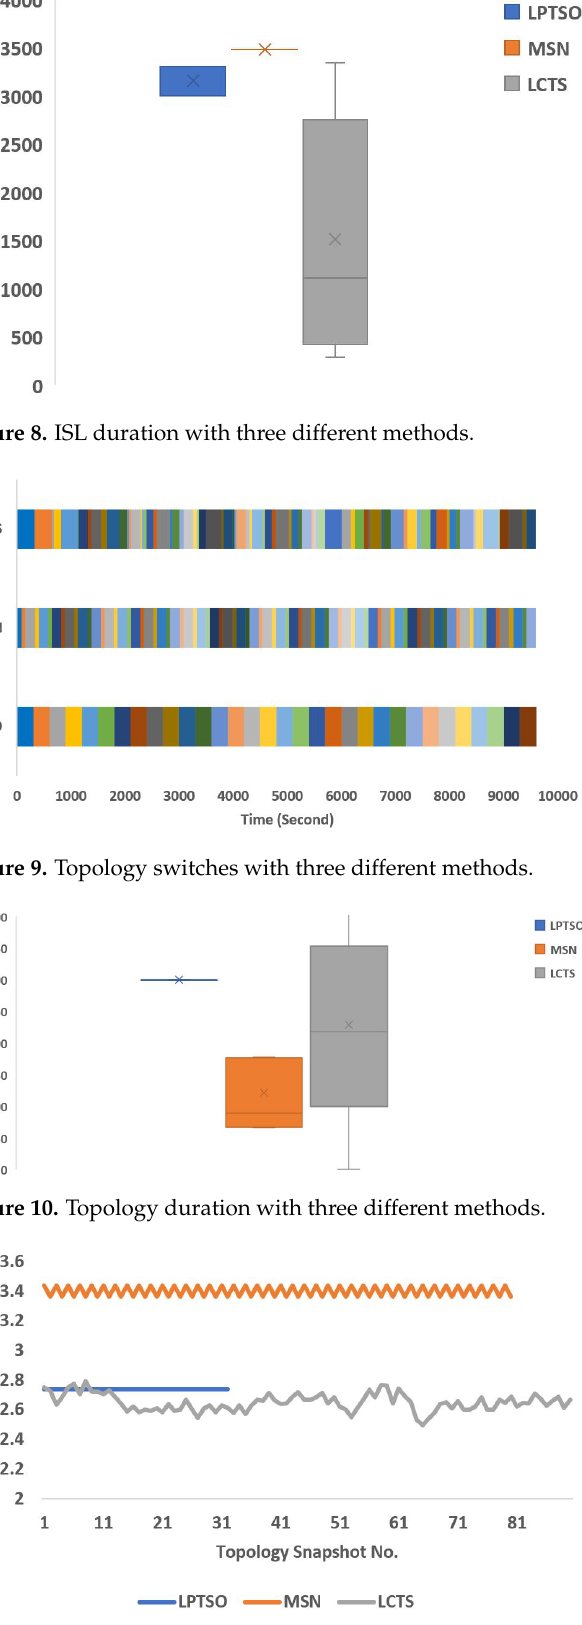
Figure 11. Average Delay with three different